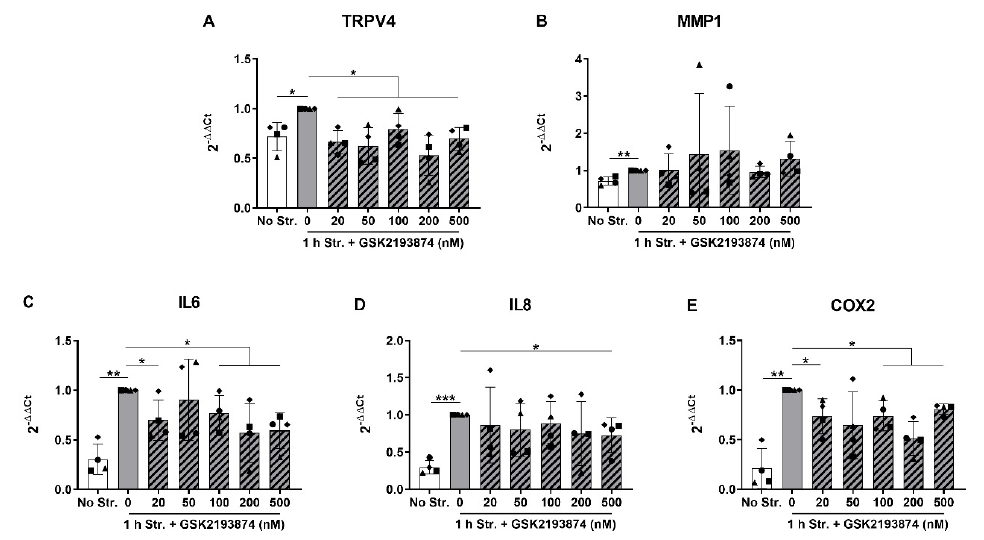
Figure 2. Gene expression of ( A ) TRPV4; ( B ), MMP1; and ( C – E ) pro-inflammatory mediators immediately after no (white bar) or 1 h (grey bars) of cyclic stretching at 20% strain and 1 Hz in the absence or presence (hatched bars) of 20–500 nM of the TRPV4 antagonist GSK2193874. n = 4 donors; mean ± SD; * p < 0.05, ** p < 0.01, *** p < 0.001.